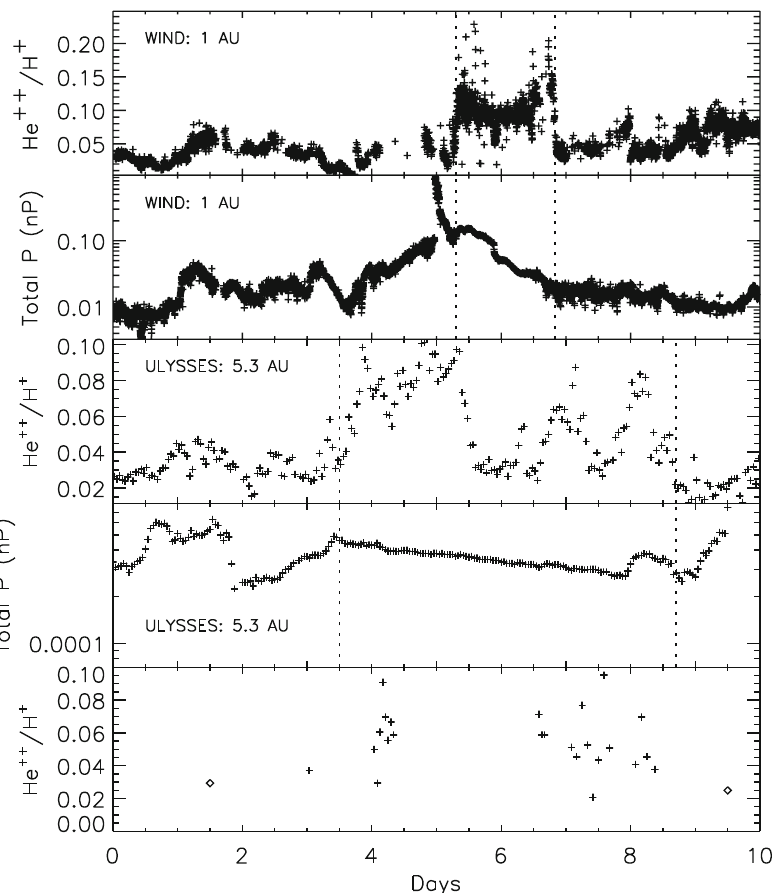
Fig.25 AnICMEdetectedbyWindat1AU,Ulyssesat5.3AUandVoyager2at58AU(bottompanel)using the total pressure (magnetic + plasma) perpendicular to the magnetic field (not available from Voyager 2) and alpha to proton ratio (He ++ / H + ). The data from different spacecraft are time-shifted to align the ICMEs. Image reproduced by permission from Richardson et al. (2006); copyright by COSPAR (see also references